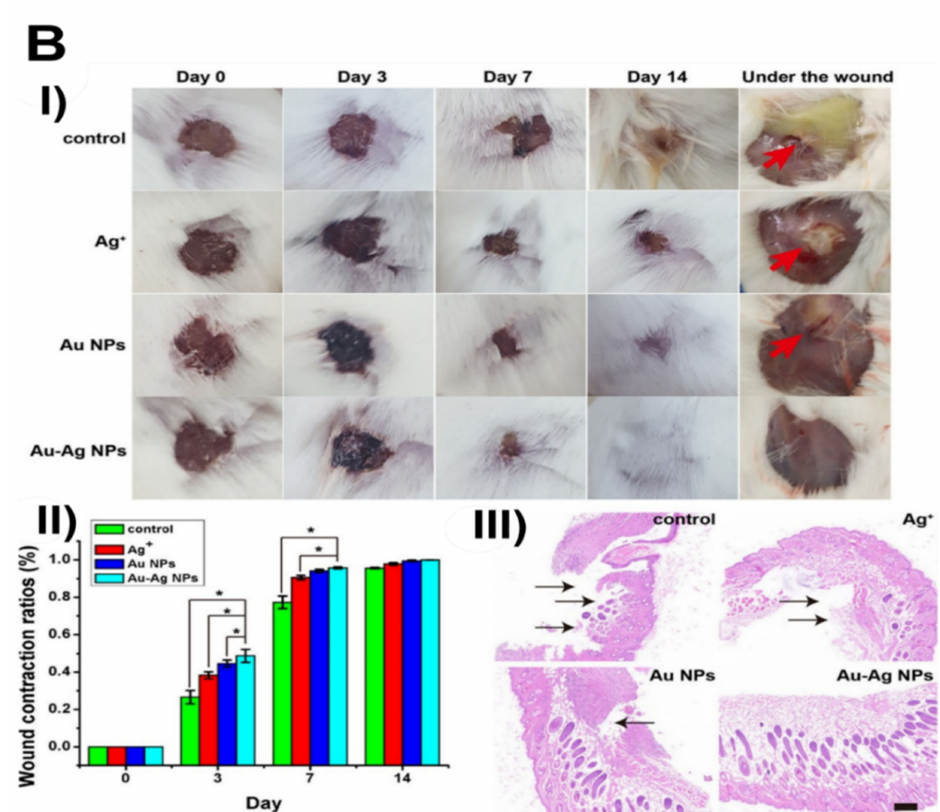
Figure 8. ( A ) Bimetallic Au–Ag NPs showing wound-healing activity in an in vivo rat model. ( B ). ( B - I ) Wound-healing activity in the mice infected with E. coli. ( B - II ) Wound contraction ra- tios in E. coli -infected mice over 0–14 days after treatment with different metallic nanoparticles. ( B - III ) Histopathological evaluation of the healed wound after 14 days of treatment with different formulations is presented. In control and monometallic formulation, the wound was not completely healed and damage to the dermis was visible, whereas bimetallic nanoparticles showed completed wound healing without any damage to the epidermis of the skin. * it denotes significant change. Reproduced with permission from ref. [147], Figure 8 (ACS Publication ®